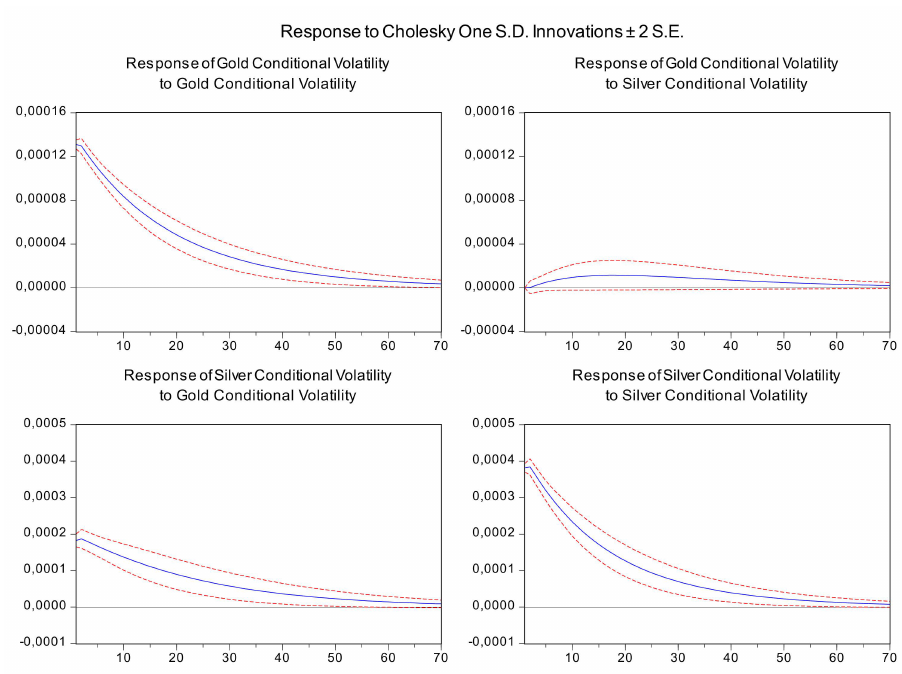
Figure 4. Weekly